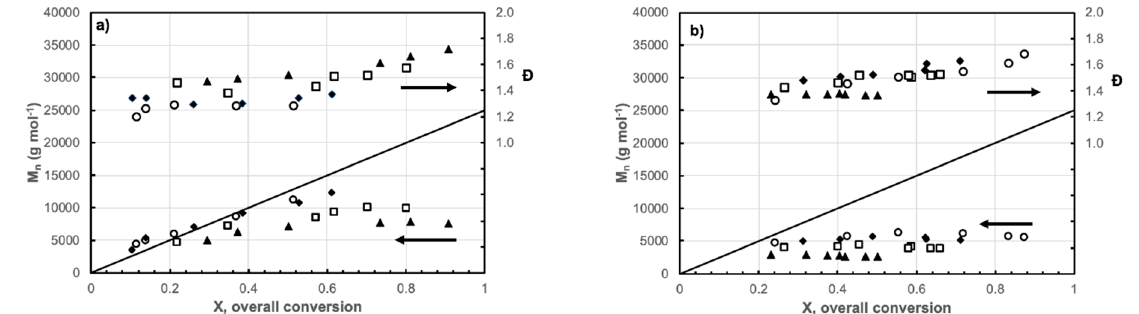
Figure 3. Number average molecular weight M n and dispersity Đ versus overall conversion (X) for DBI/S copolymerization at ( a ) initial molar compositions of DBI f DBI,0 = 0.1–0.4 (f DBI,0 = 0.1 are open circles 〇 , f DBI,0 = 0.2 are solid diamonds , f DBI,0 = 0.3 are open squares , and f DBI,0 = 0.4 are solid triangles ) and at ( b ) initial molar compositions of DBI f DBI,0 = 0.5–0.8 (f DBI,0 = 0.5 are open circles 〇 , f DBI,0 = 0.6 are solid diamonds , f DBI,0 = 0.7 are open squares , and f DBI,0 = 0.8 are solid triangles ).